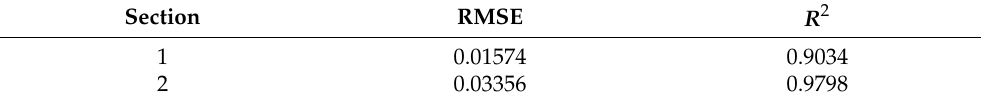
Figure 7. Comparison of free ‐ surface velocity vectors between the experimental data and simulation results: ( a ) Free ‐ surface velocity vectors of experimental data; ( b ) Free ‐ surface velocity vectors of simulation results. Table 3. RMSE and R 2 values of mean streamwise velocities on the two cross-sections. Section